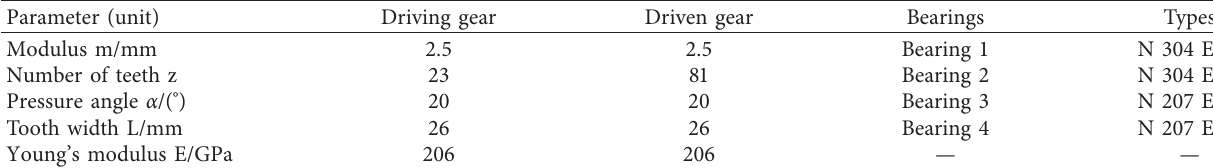
Table 4: Main parameters of the gear-shaft-bearing system.